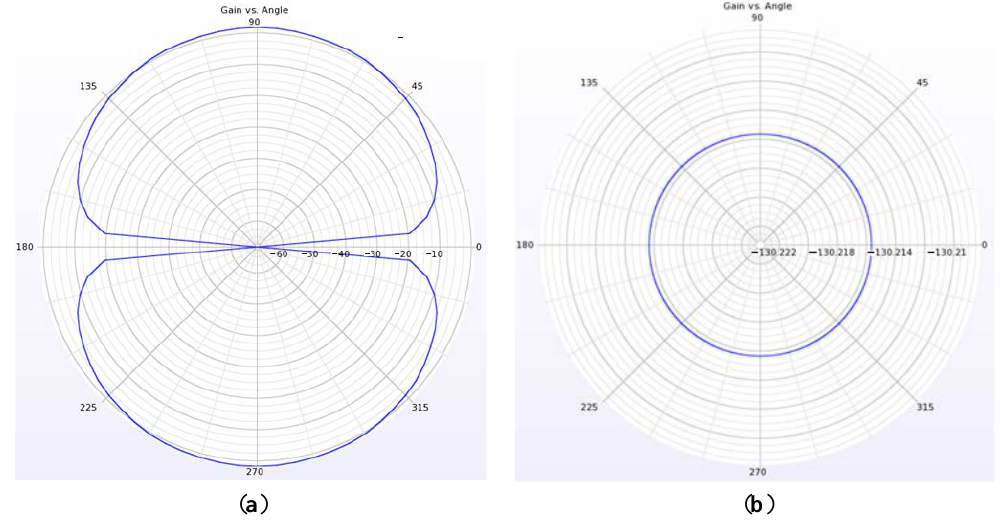
o = 0 φ ); ( b ) Radiation